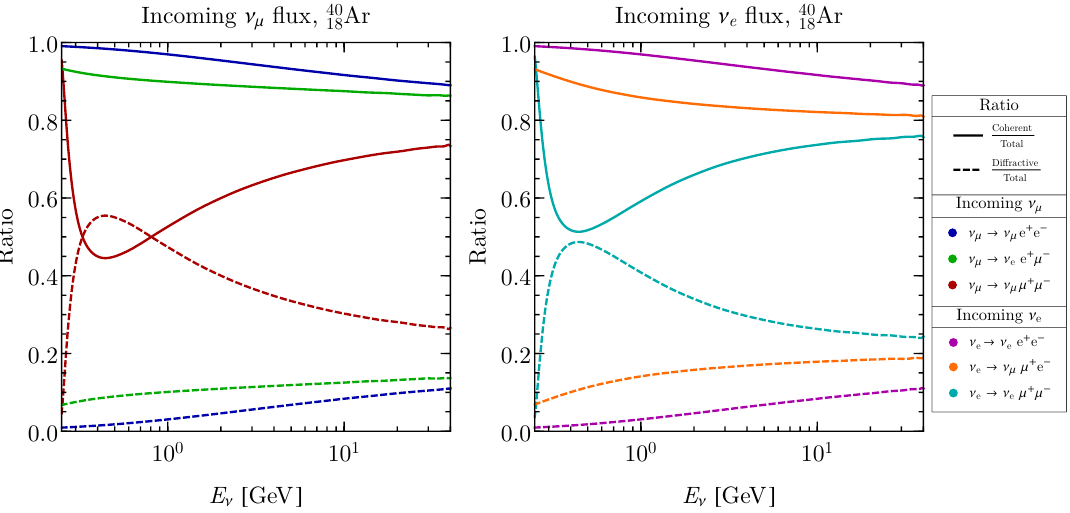
Figure 6 . On the left (right) panel we show the ratio of the coherent (full lines) and the di(cid:11)ractive (dashed lines) contributions to the total trident cross section for an incoming (cid:13)ux of (cid:23) (cid:22) ( (cid:23) e ) as a function of E (cid:23) for an 40 Ar